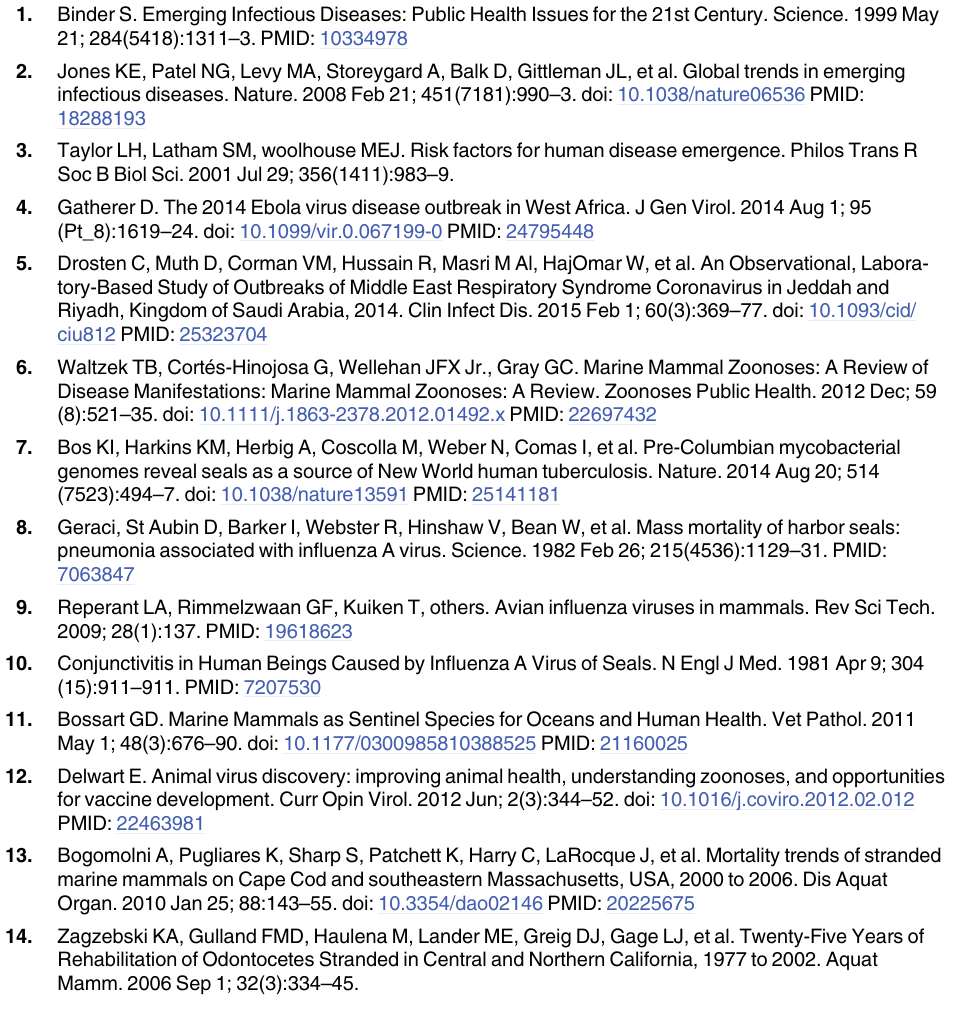
S1 Table. SIMPER analysis output of the top 20 bacterial genera similarities within and between com (comparative) and UCD (unknown cause of death) harbor